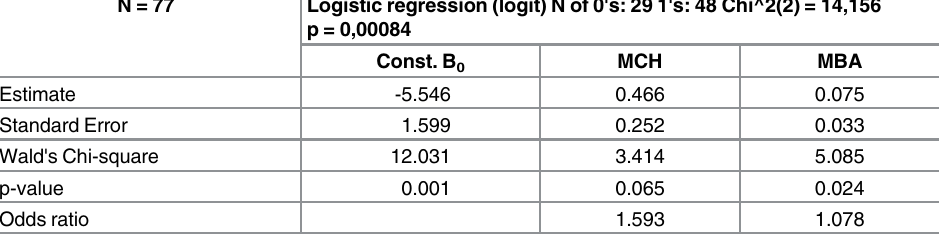
Table 3. Logistic regression results — model